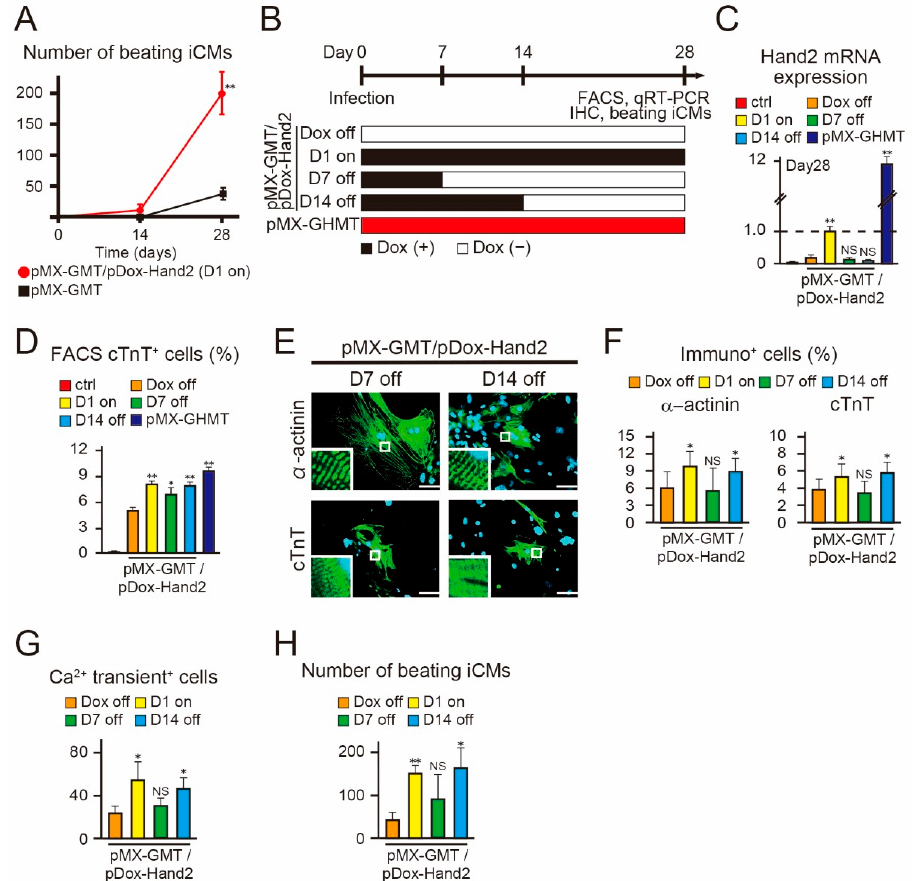
Figure 4. Hand2 transgene expression for the first two weeks is sufficient to promote cardiac reprogramming. ( A ) Time course of the total number of beating cardiomyocyte-like cells (iCMs) in mouse embryonic fibroblasts (MEFs) induced with pDox-Hand2/pMX-GMT or pMX-GMT after two and four weeks ( n = 3 independent triplicate experiments); ( B ) schematic representation of the strategy to determine the optimal timing of Hand2 expression for cardiac reprogramming. Doxycycline (Dox) was administered for different intervals, four weeks (D1 on), seven days (D7 off), and fourteen days (D14 off), after transduction of cells with pDox-Hand2/pMX-GMT; ( C ) qRT-PCR for Hand2 expression in the indicated samples after four weeks ( n = 3 independent triplicate experiments); ( D ) FACS analyses for cardiac troponin T (cTnT) expression in the indicated samples after four weeks. Quantitative data are shown ( n = 3 independent triplicate experiments); ( E ) immunocytochemistry for α -actinin and cTnT after four weeks. The high-magnification views in the insets show the sarcomeric organization; ( F ) quantitation of immunopositive ( α -actinin + and cTnT + ) cells ( n = 3 independent triplicate experiments); ( G ) total number of Ca 2+ oscillation + cells in ten randomly selected fields per well after four weeks ( n = 3 independent triplicate experiments); ( H ) total number of spontaneously beating cells ten randomly selected fields per well after four weeks ( n = 3 independent triplicate experiments). All data are presented as mean ± SD. * p < 0.05, ** p < 0.01 vs. the relevant control; NS = not significant. The scale bars represent 100 µ